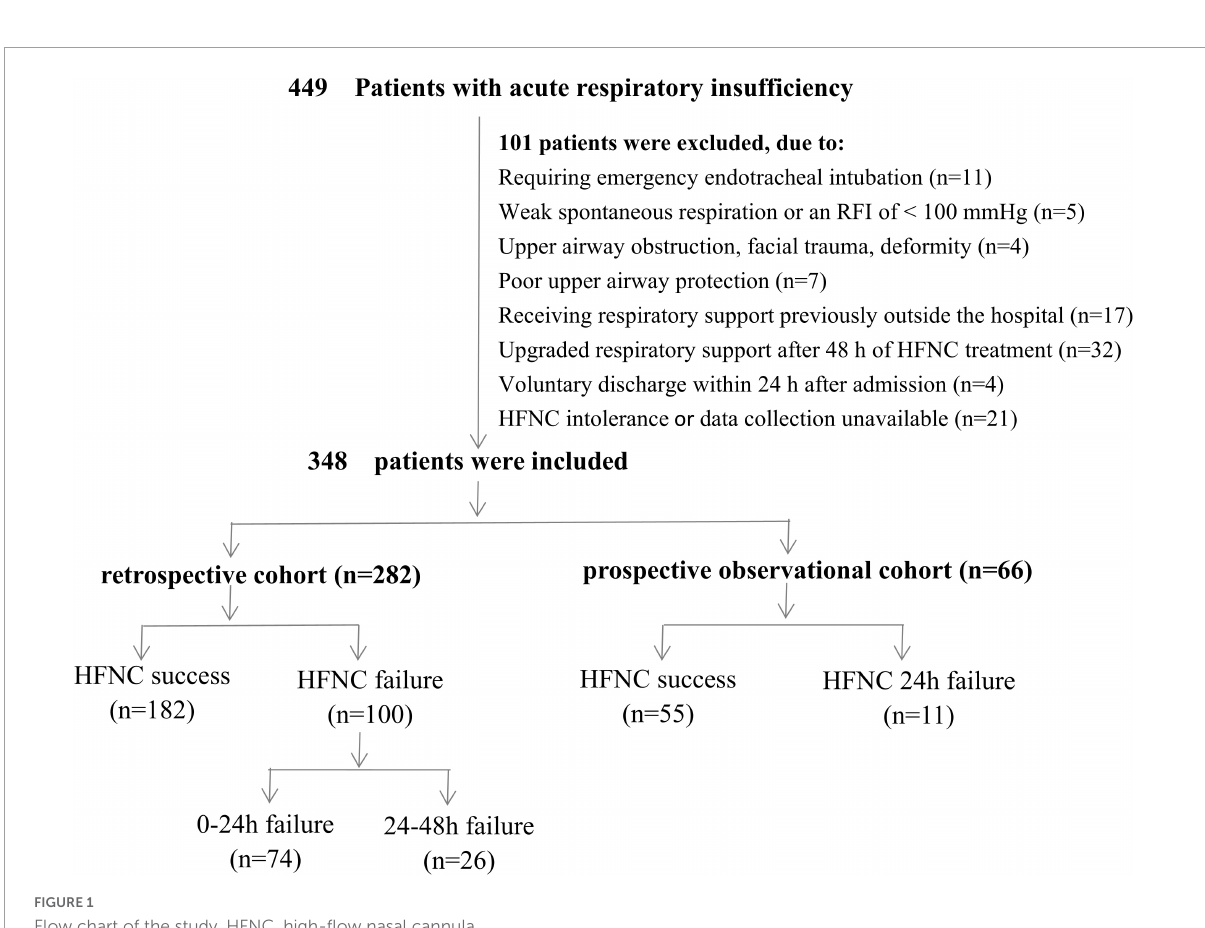
TABLE 1 Baseline characteristics of patients in the high-flow nasal cannula oxygen therapy success and failure groups.